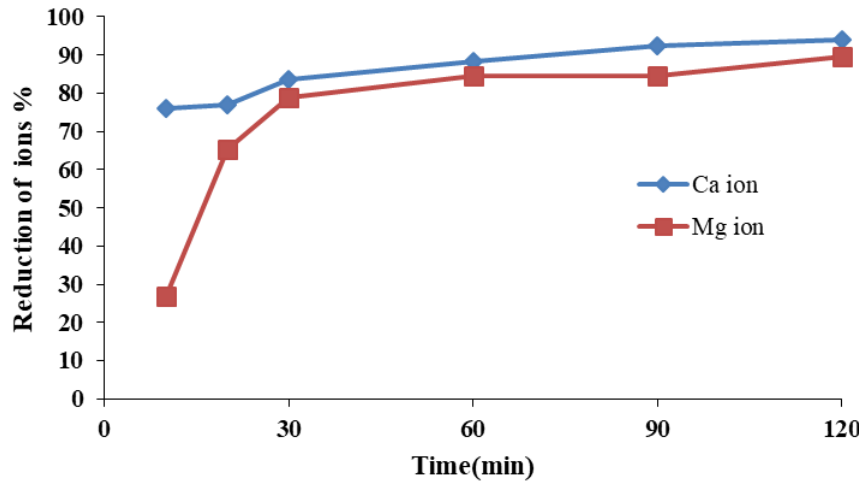
Figure 6. The effect of contact time in decreasing calcium and magnesium ions (%) in drinking water with natural zeolite at a concentration of 40 g/L.